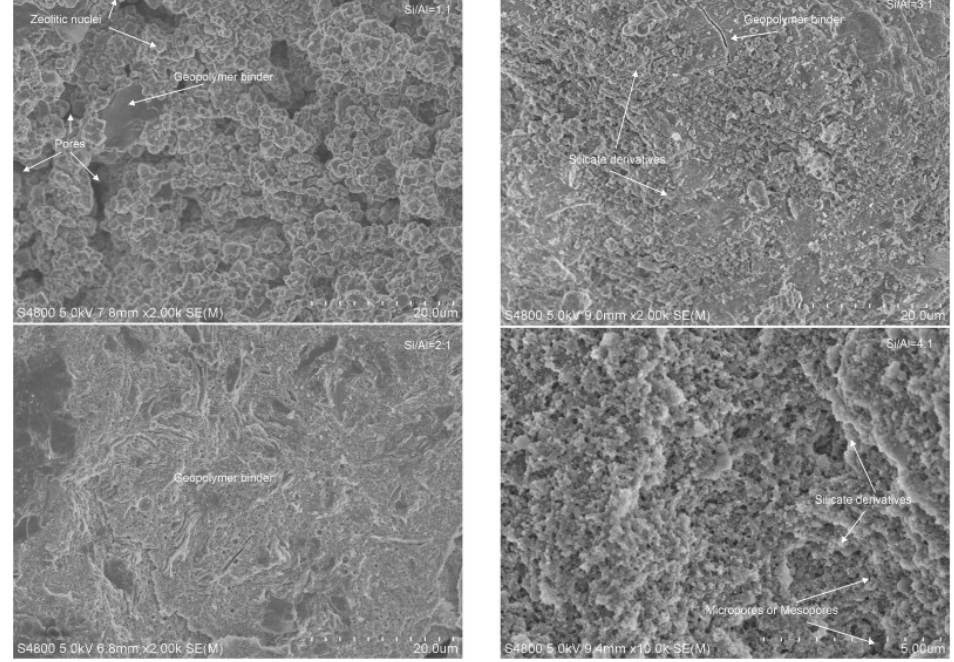
Figure 10. SEM images of MGCs synthesized at different Si/Al ratios (reproduced with permission from Wan, Q. et al., Cement and Concrete Research ; Elsevier, 2017).